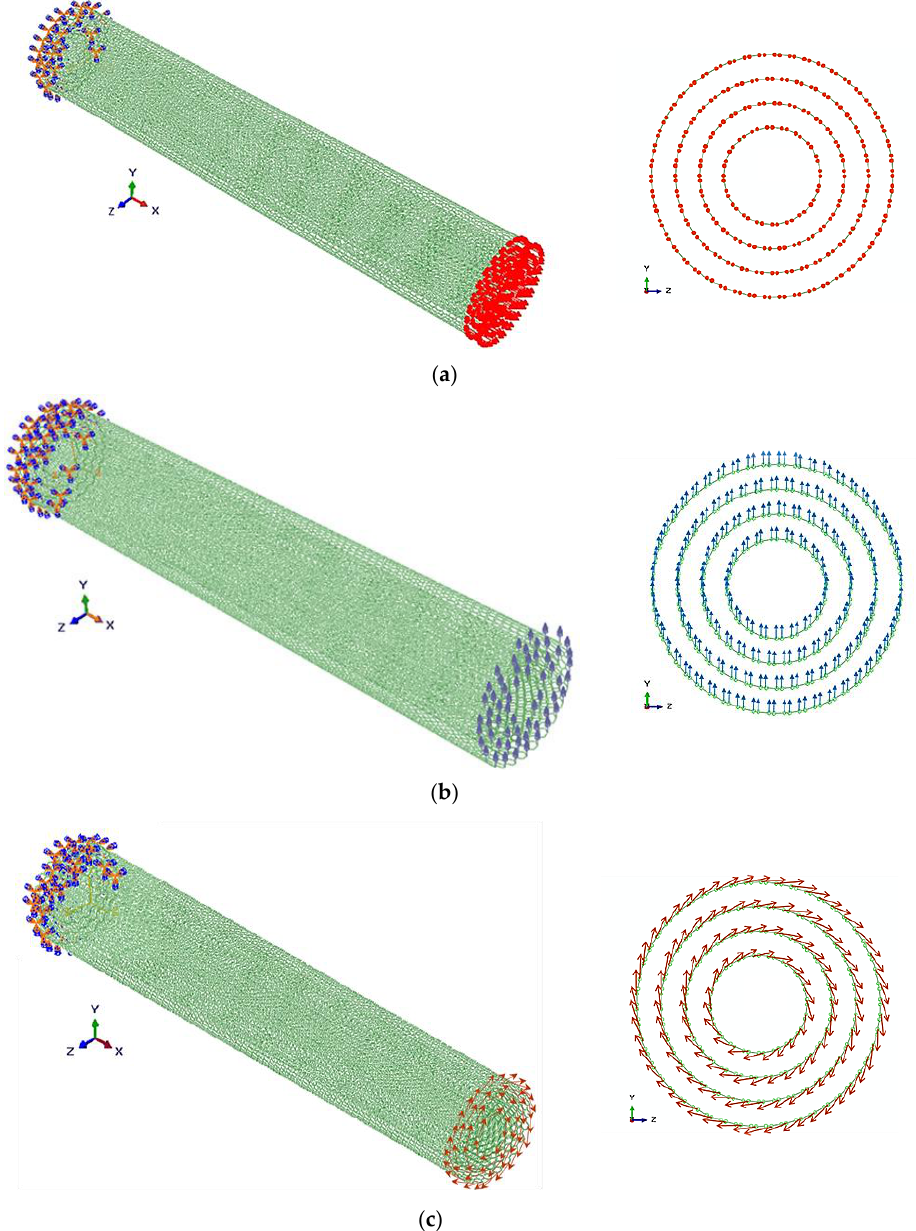
Figure 1. Loading and boundary conditions for the (10,10) (15,15) (20,20) (25,25) armchair multiwalled carbon nanotube (MWCNT): ( a ) tension, ( b ) bending, and ( c ) torsion.